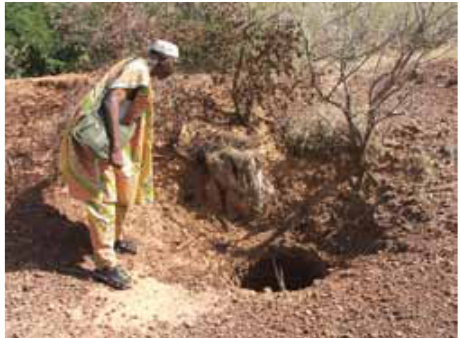
Fig. 3: Seydou Camara looking into a mine shaft at